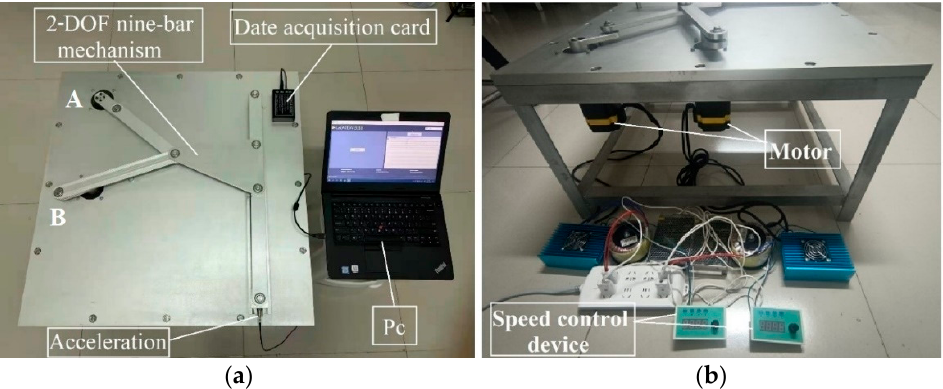
Figure 13. The 2- DOF nine–bar mechanism test bed. ( a ) Vertical view. ( b ) Lateral view.